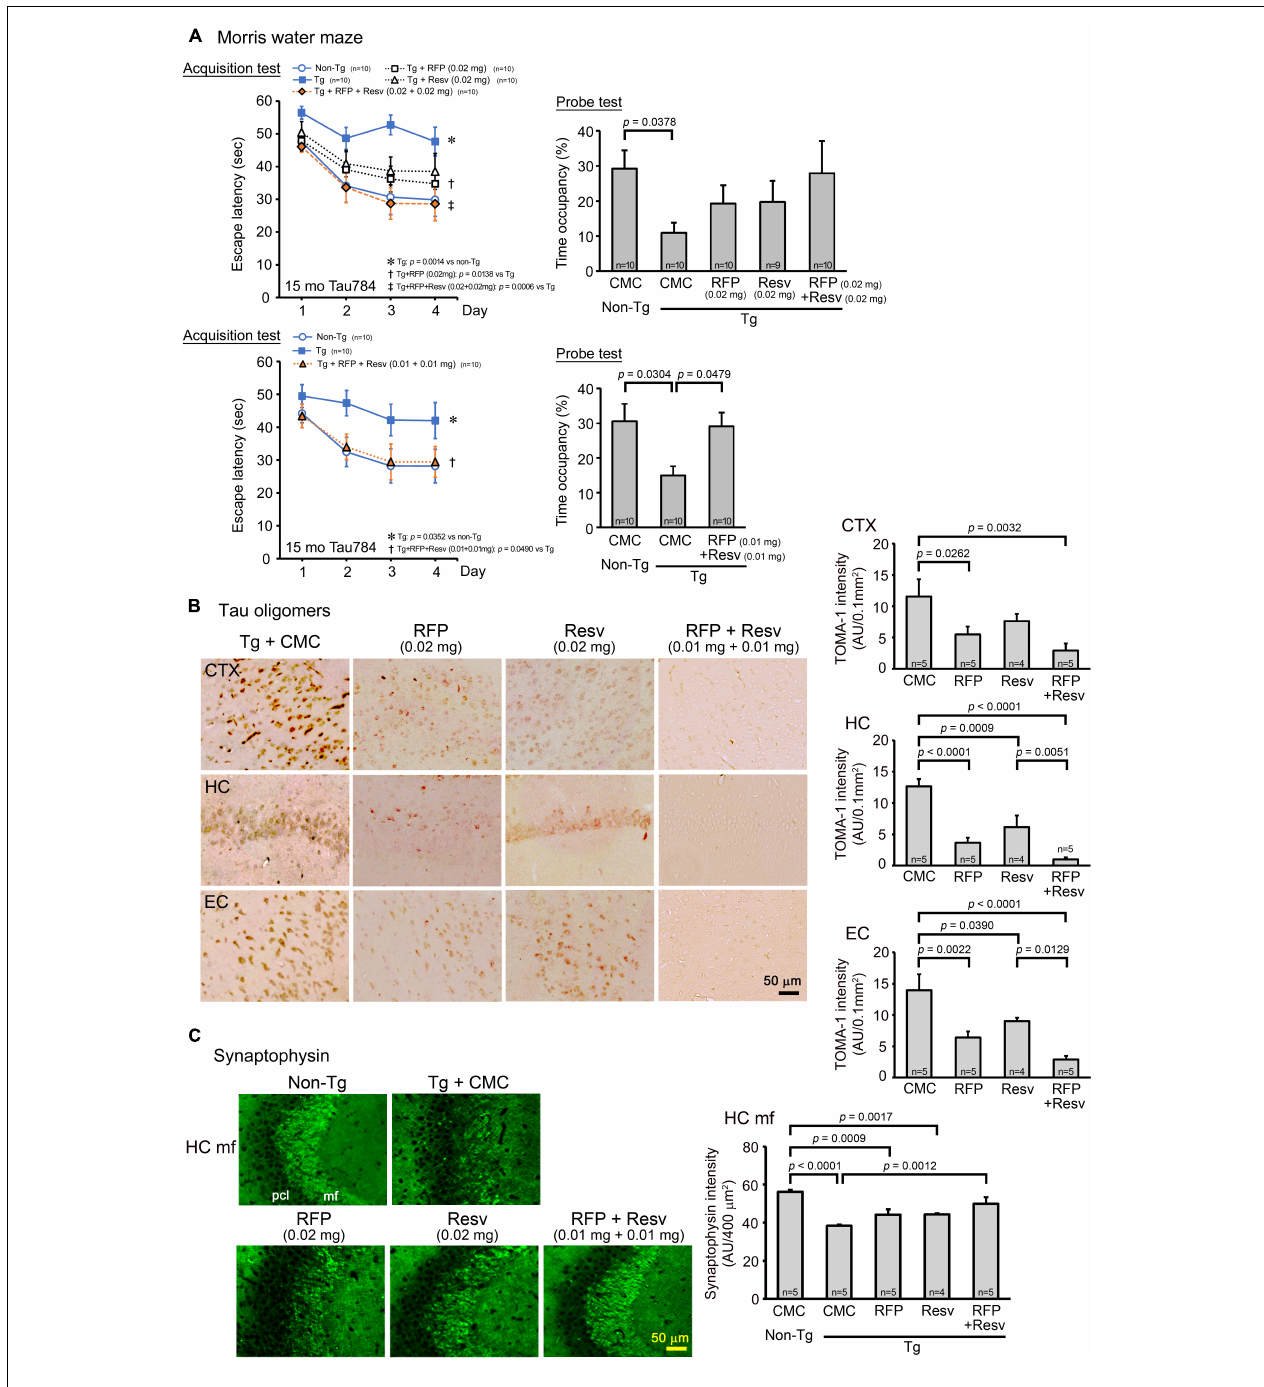
FIGURE 4 | Effects of intranasal rifampicin and resveratrol combination on memory and tau oligomer-related pathologies in tau784 mice. Drug solution containing 0.02 mg rifampicin (RFP) alone, 0.02 mg resveratrol (Resv) alone, 0.02 or 0.04 mg combinatorial medicine (0.01 or 0.02 mg each drug), or carboxymethylcellulose (CMC) was intranasally administered every day into 13–14-month-old mice for 1 month. (A) In the Morris water maze, the combinatorial medicine showed a significant improvement of mouse memory to almost the same level as non-Tg littermates even at the lower dose. This suggests a synergistic effect of rifampicin and resveratrol in ameliorating mouse cognition. (B,C) After the water maze task, brain sections were stained with antibodies for tau oligomers (TOMA-1) and synaptophysin. (B) The levels of tau oligomers in the cerebral cortex (CTX), hippocampus (HC), and entorhinal cortex (EC) were significantly attenuated by rifampicin alone and low-dose (0.02 mg/day) combinatorial medicine. (C) The level of synaptophysin in the hippocampal mossy fibers (HC mf) was significantly recovered by the combinatorial medicine (0.02 mg/day) to a level similar of non-Tg littermates. pcl, pyramidal cell layer. AU, arbitrary unit. Values in each figure represent the mean ±